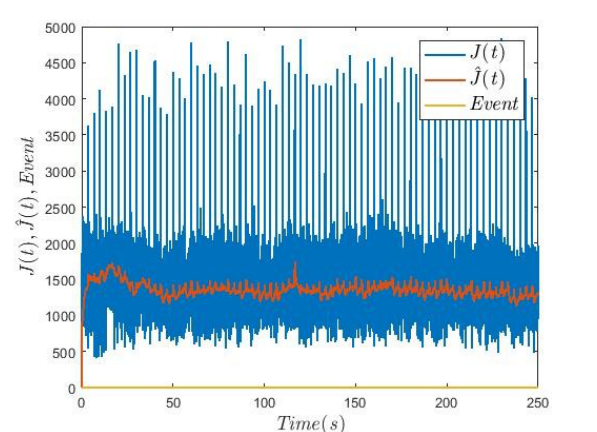
Figure 6. Graphs of the criterion   J t , smoothed estimate   ˆ J t , and event indicator Event . The analyzed video does not contain seizures